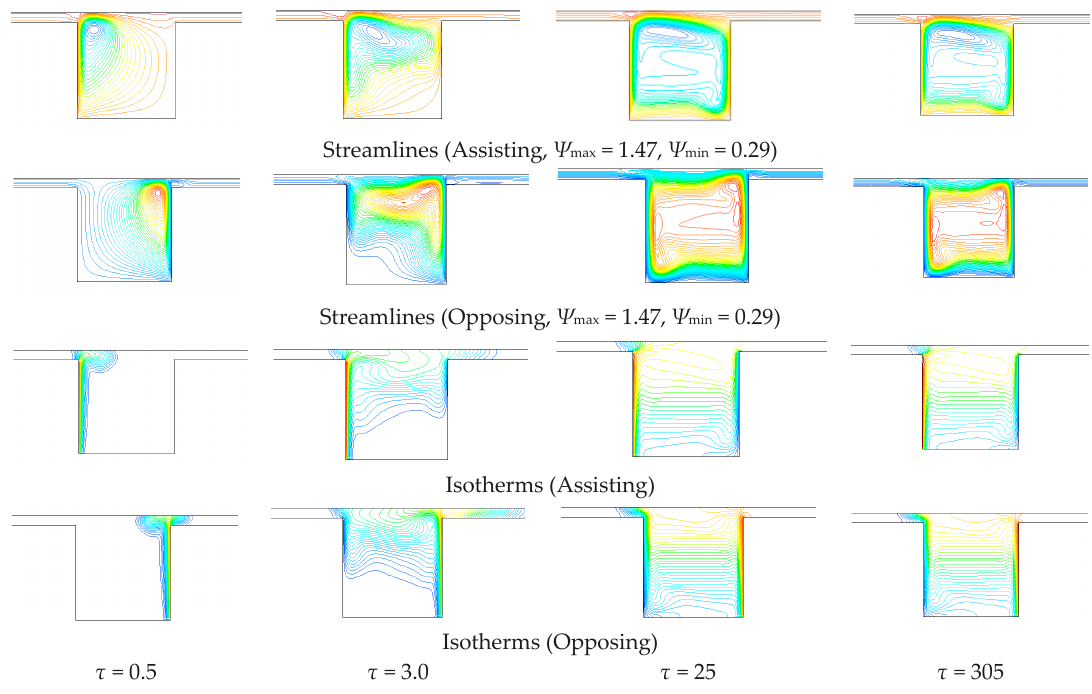
Figure 11. Streamlines and isotherms for Re = 10, aspect ratio (AR) = 1.0 and Ri = 6.58 × 10 4 .